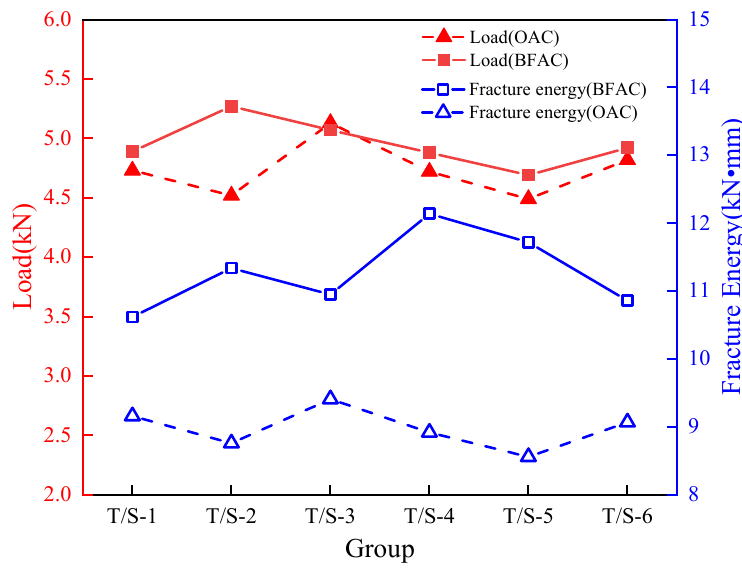
Figure 10. The maximum load and fracture energy of different specimens.